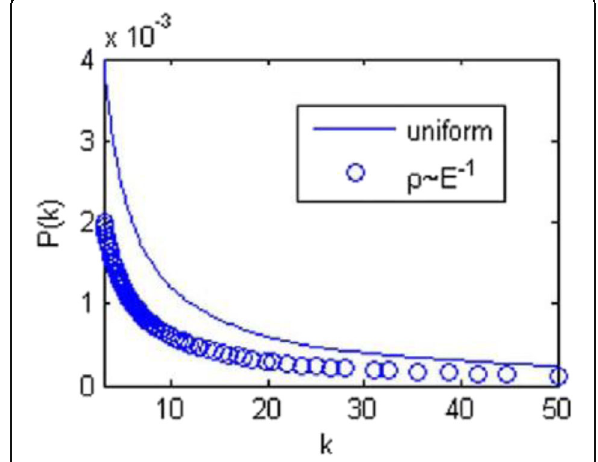
Fig. 2 Degree of evolution network with different local-scope